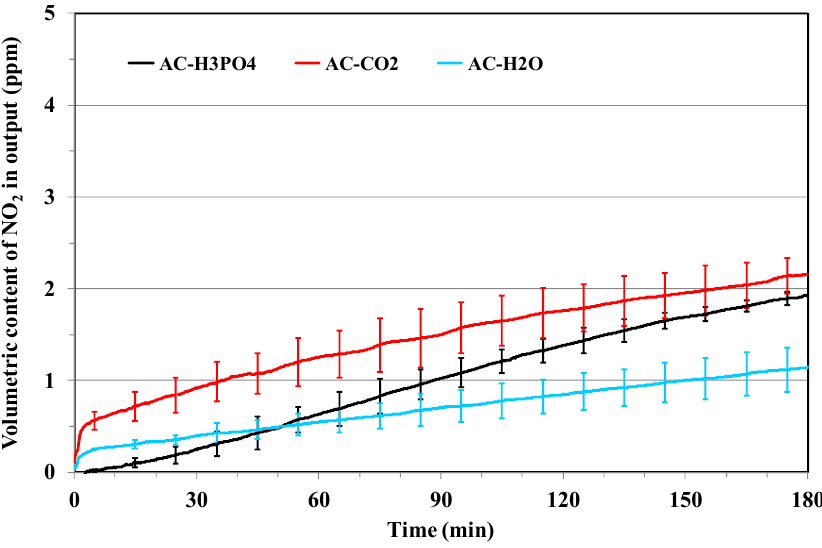
Figure 7. Breakthrough curves of NO 2 through three differently activated sorbent samples made from olive stones (c 1 NO 2 = 5 ppm, c 1 NO = 0 ppm, 23 °C, 50% RH, v = 0.2 m/s, m Sorb = 2 g).